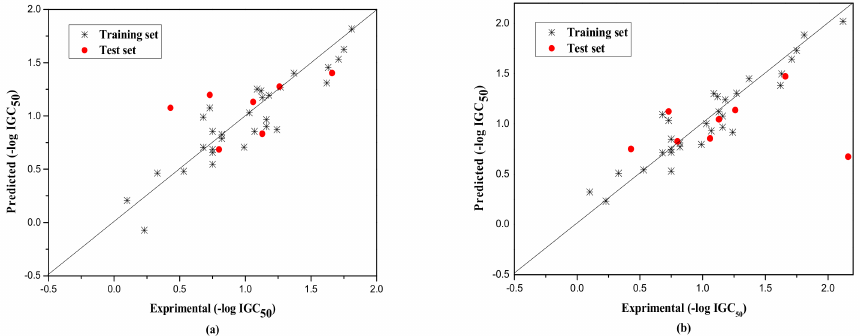
Figure 3. Plot of the predicted versus experimental − log IGC 50 including the training and the test set compounds of Group 3 by MLR model ( a ) and by RBFNN model ( b